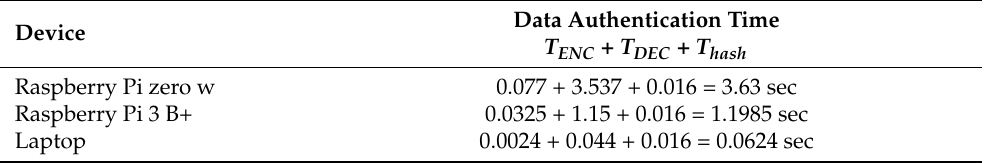
Table 6. Average time required for data authentication.